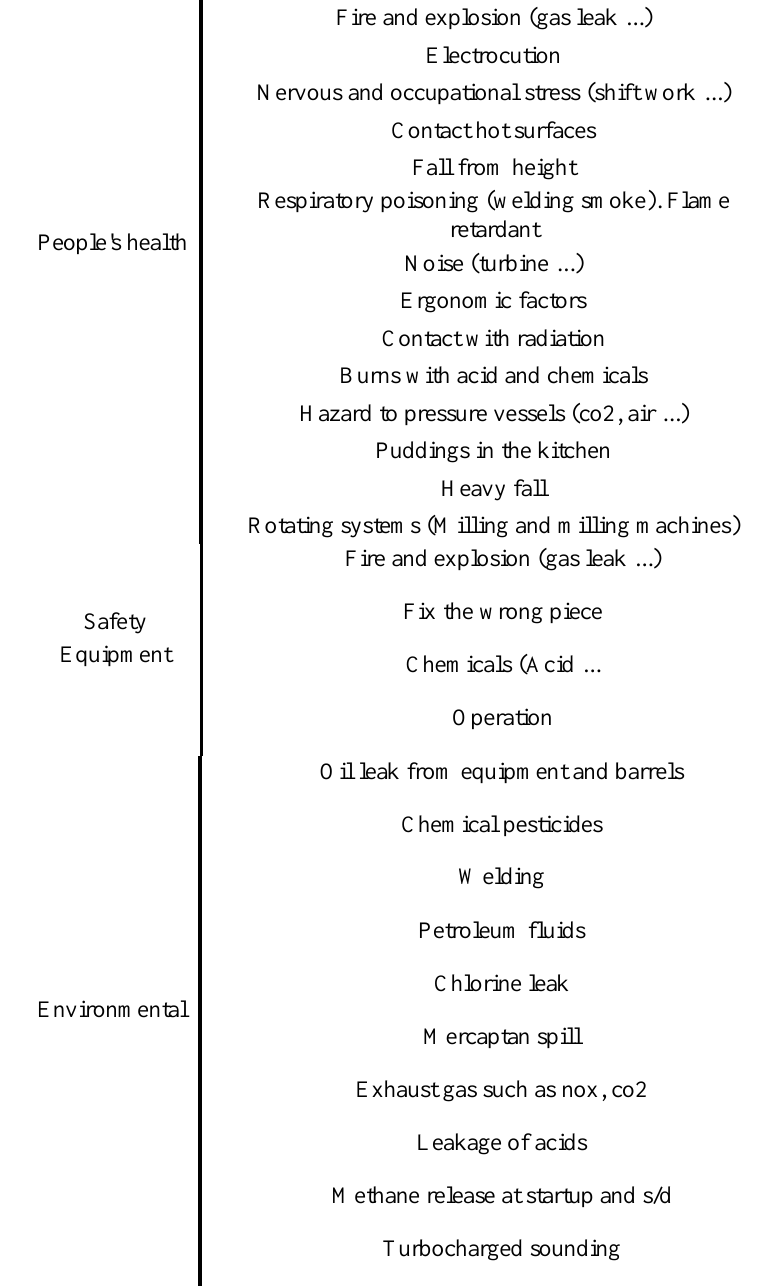
Table 1. Responsible supplier